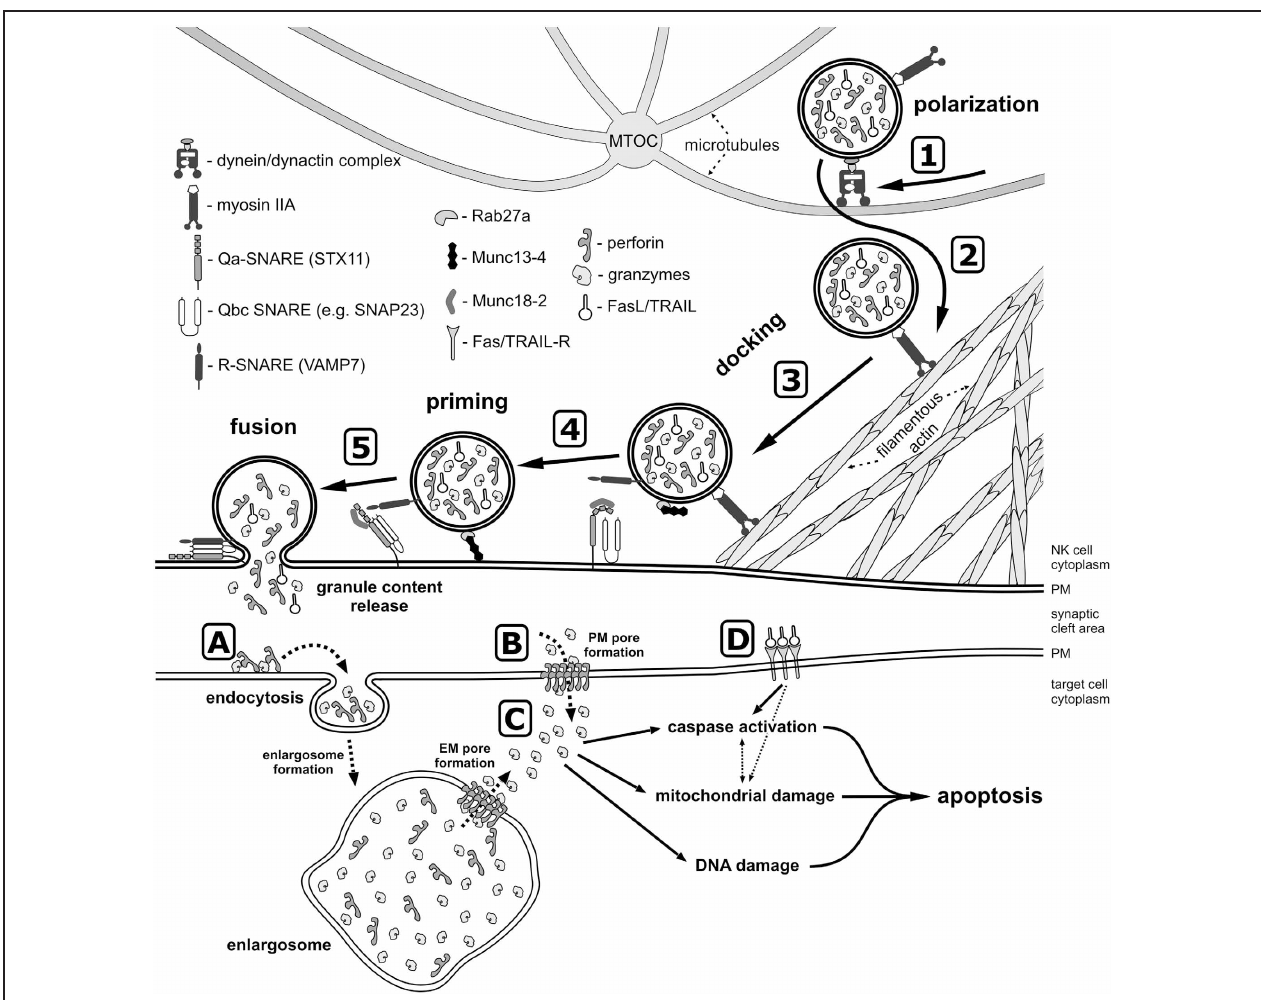
FIGURE 2 | A model of lytic granule exocytosis from human NK cell. In response to the engagement of NK cell activating receptors and initiation of signaling cascades (not depicted), the lytic granules move along the microtubules toward the MTOC in the dynein-dynactin complex-dependent manner (1). The MTOC and the granules then polarize toward the NK-target cell contact area, where granules switch from microtubules to the filamentous actin network at the immunological synapse (2) and navigate through the cortical filamentous actin meshwork as a result of the actin motor protein myosin IIA activity (3). This allows the lytic granules to get into close proximity of the plasma membrane (PM), and dock at the membrane due to activity of Rab27a and Rab27a-mediated recruitment of Munc13-4, aswellas through the recognition of syntaxin 11 (STX11) and Munc18-2, possibly by the R-SNARE protein(s) present at the lytic granule membrane. The docked granules are then primed (4) by Munc13-4 in response to calcium flux (not shown), likely by the Munc13-4-mediated switch of STX11 to an open conformation (by removal of Munc18-2), and/or by Munc13-4 forming an initial bridge between the granule membrane and the plasma membrane. Finally, the granule-associated